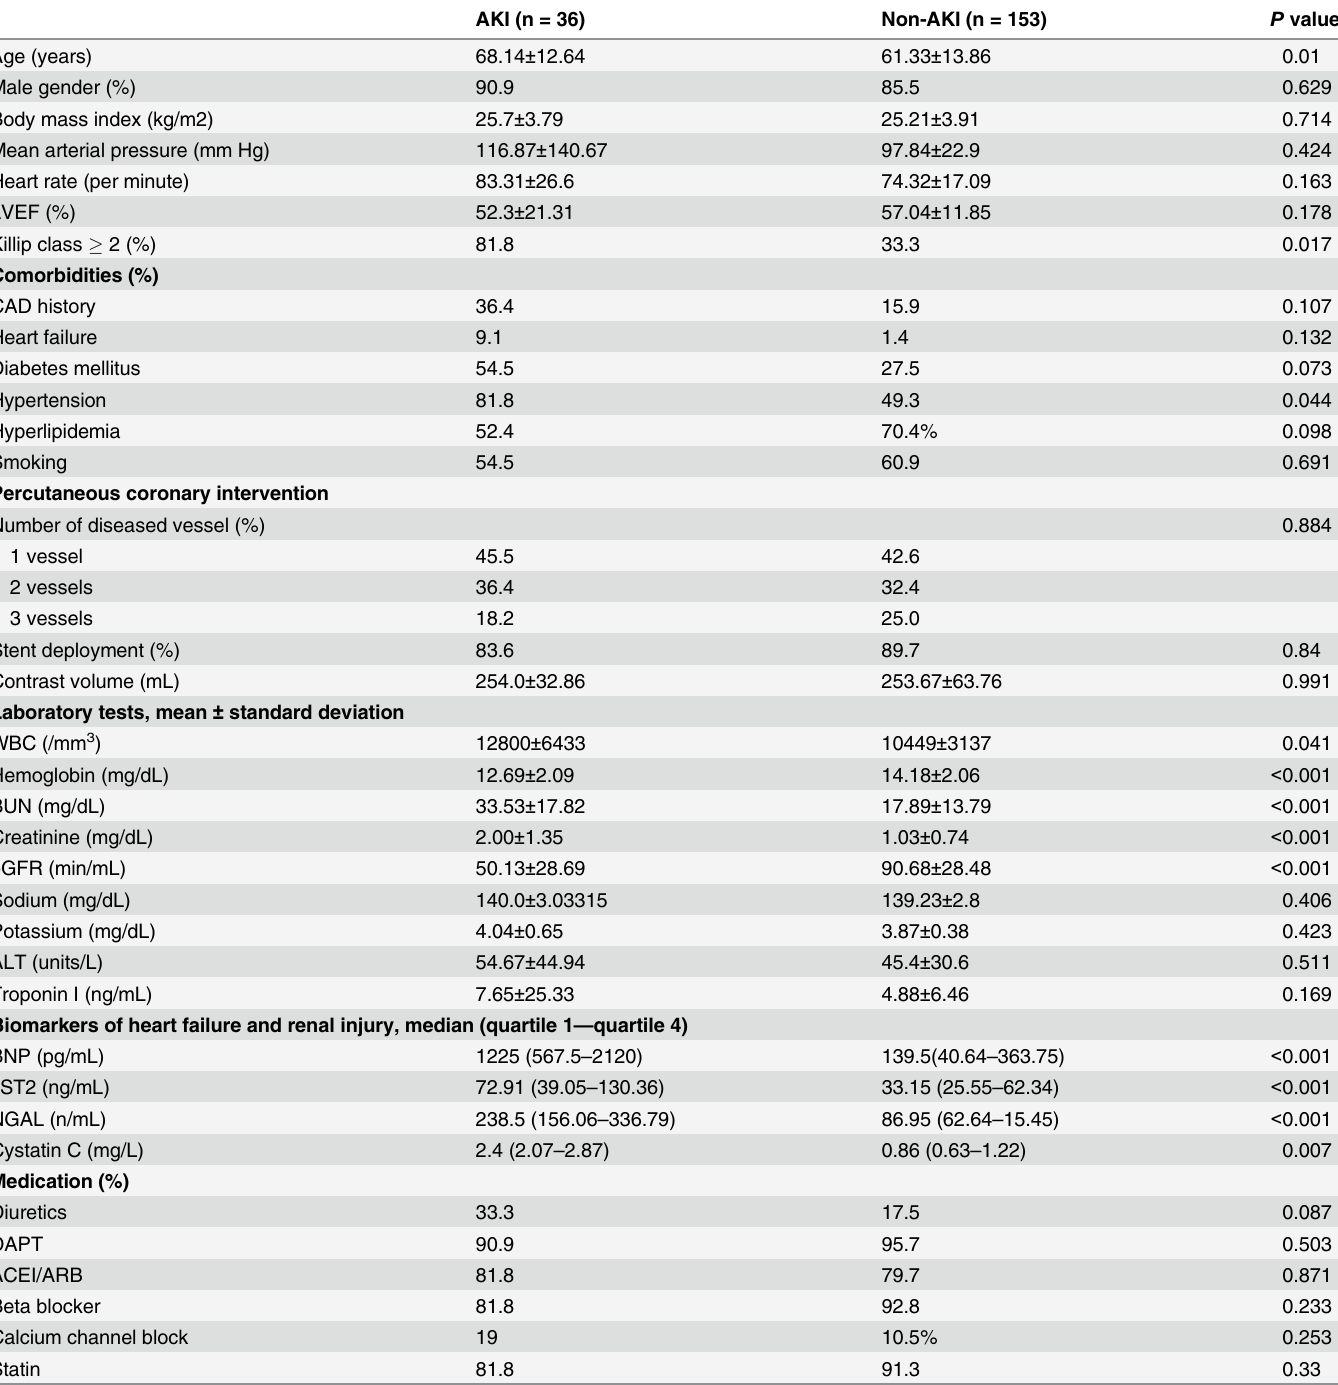
Table 1. Baseline